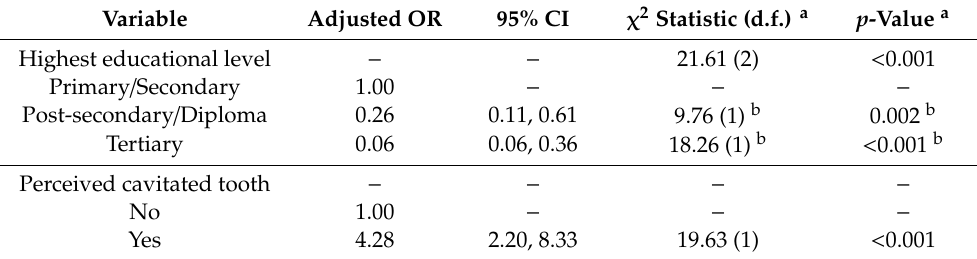
Table 3. Factors associated with untreated dental caries using multiple logistic regression. Variable Adjusted OR